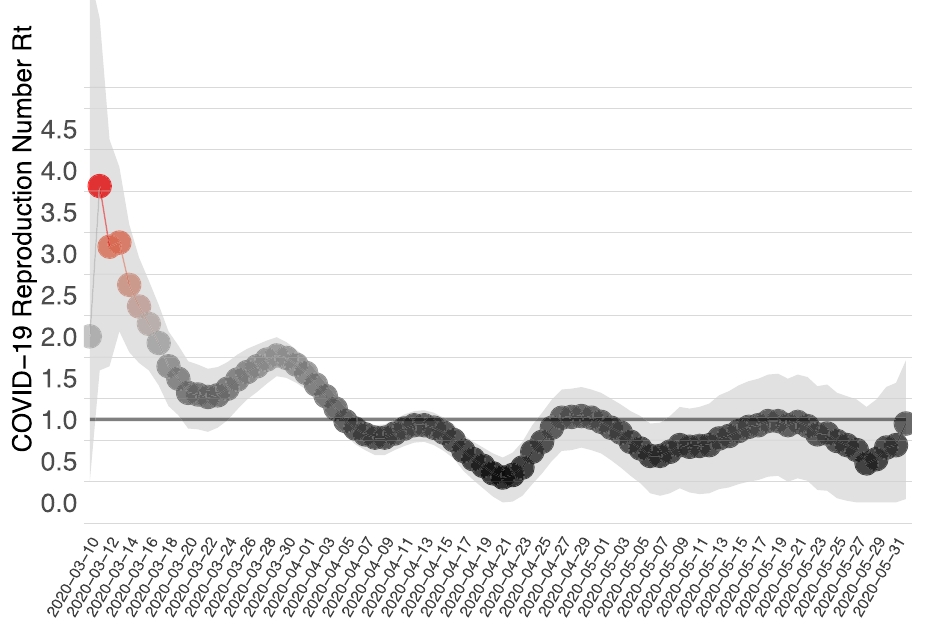
Figure 11. Median value (red) and 95 % credible intervals for the posterior distributions of the effective reproduction number in compartmental model 3, for the period between 05/03/2020 and 01/06/2020.